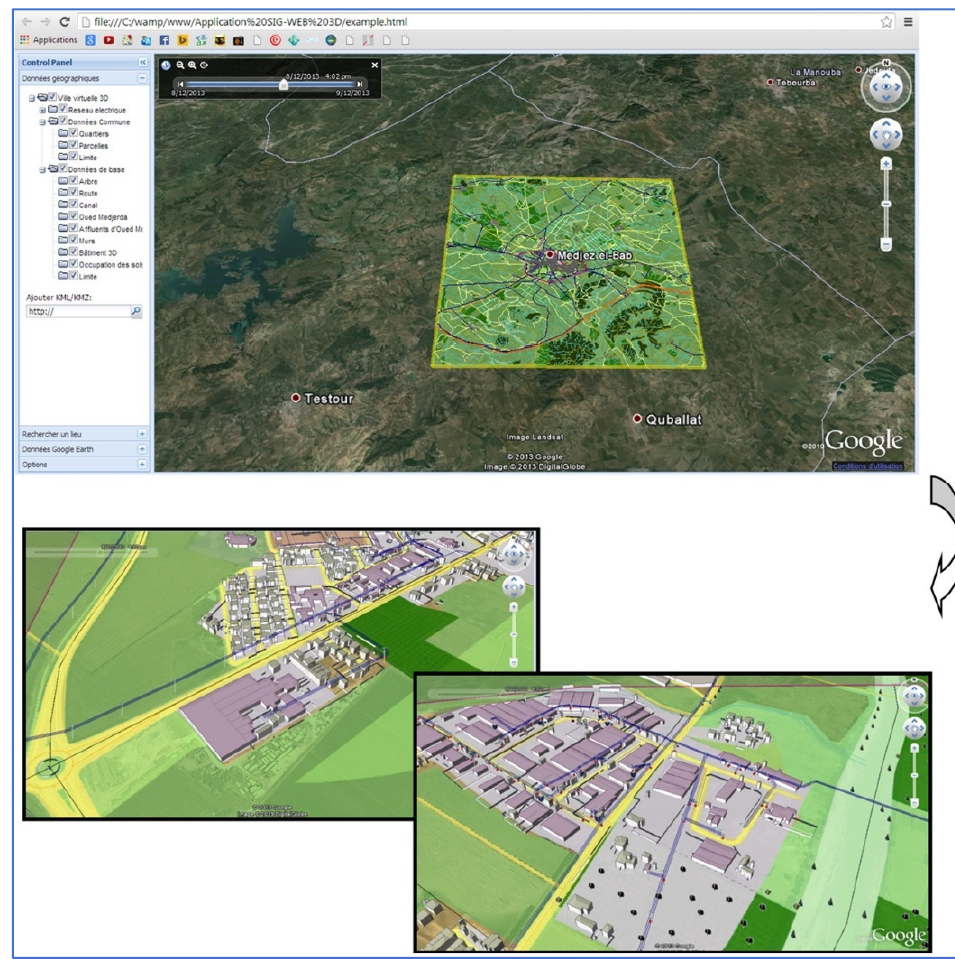
Figure 10. 3D web cartographic interface.